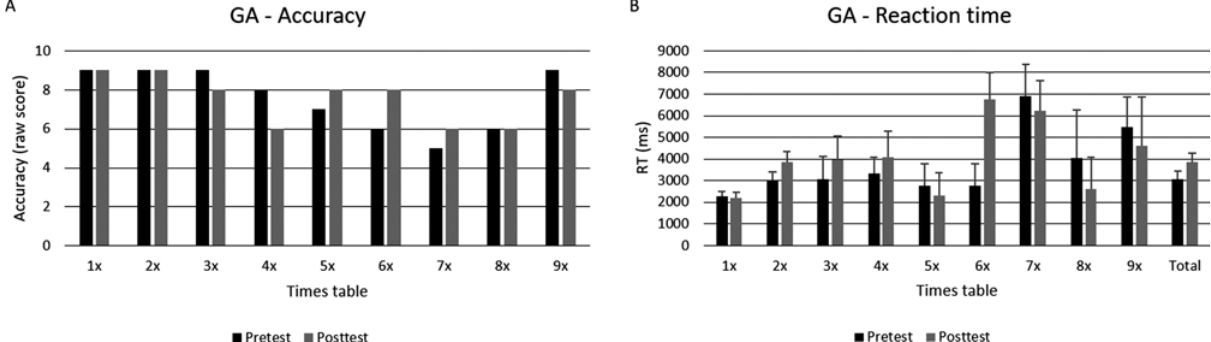
figure 2. GA’s raw score and median reaction time (ms) in the